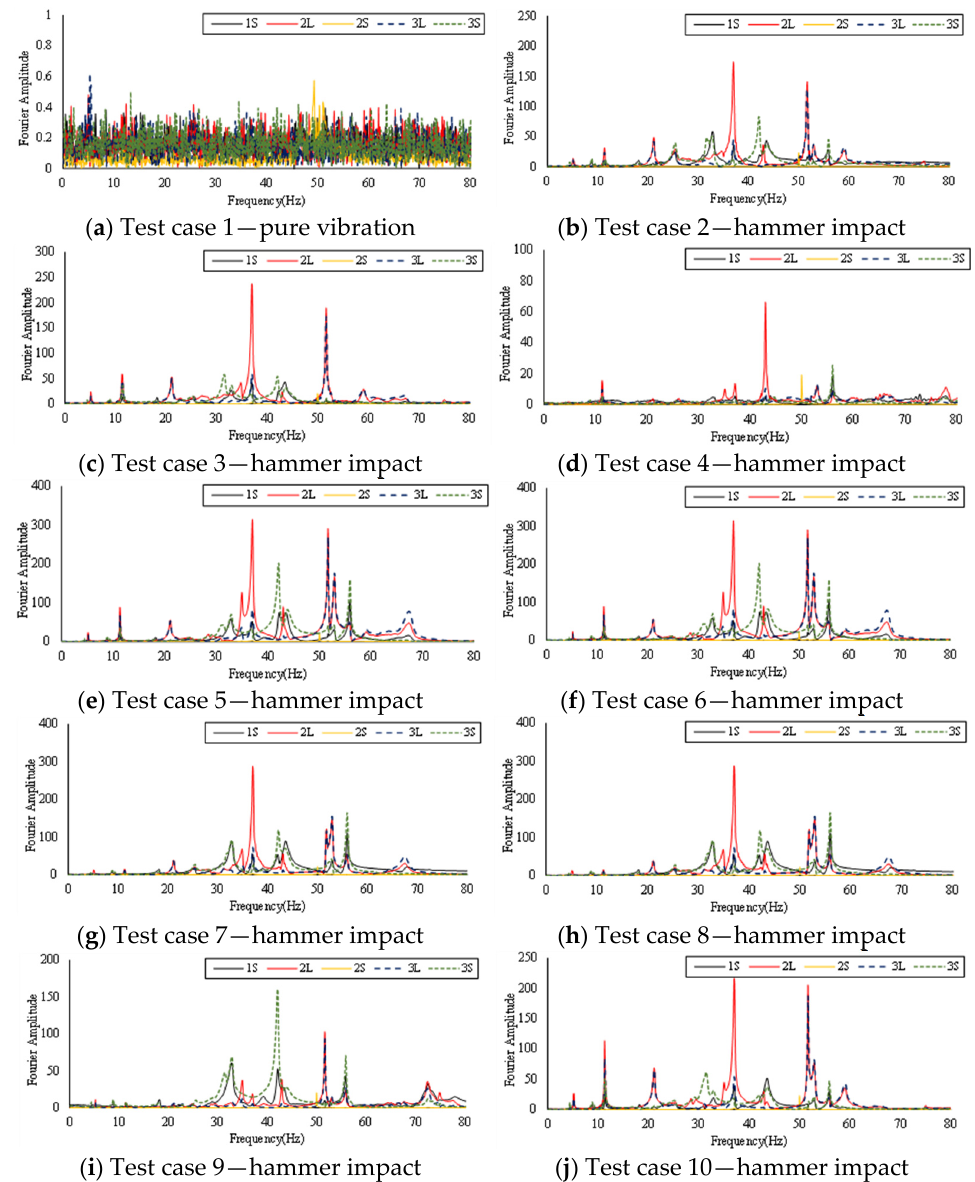
Figure 7. Fast Fourier transforms of recorded accelerations.